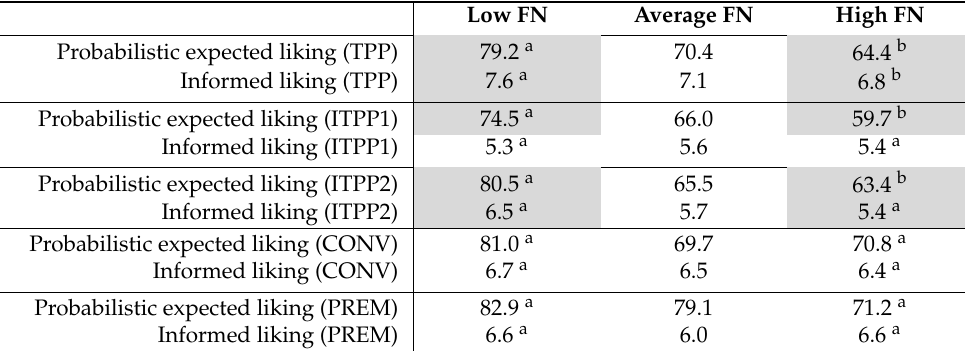
Table 8. The FN associations with the expected